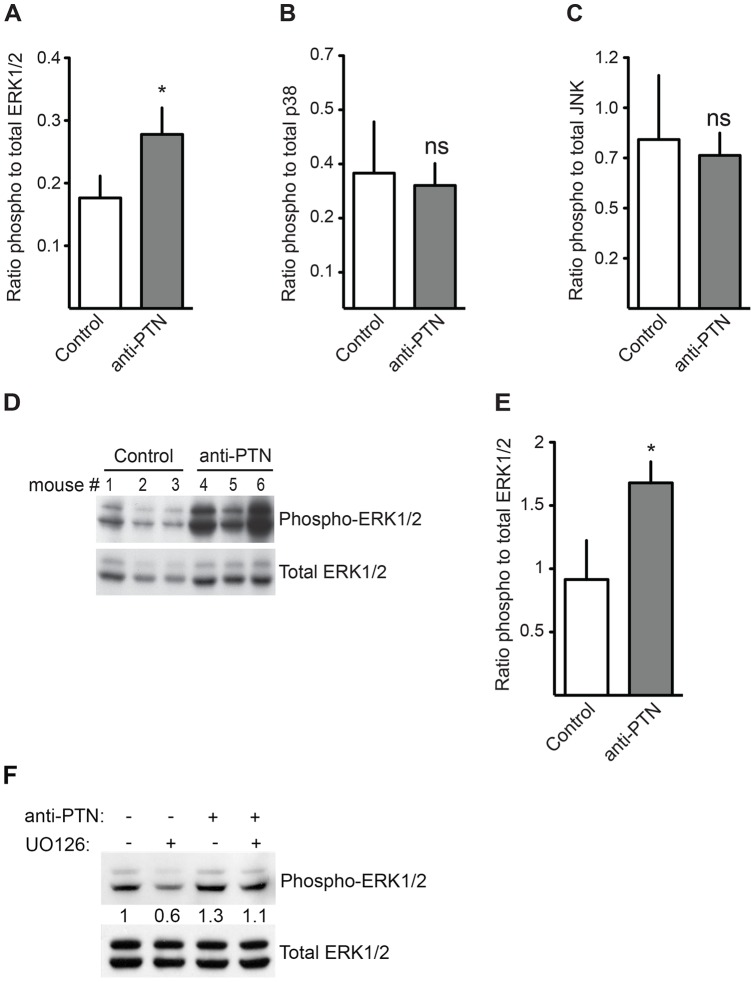
PTN effect on MAP kinase pathway activity in developing mammary glands.Phospho-ERK1/2 (A), phospho-p38 (B), and phospho-JNK (C) in whole mammary gland extracts from anti-PTN treated mice (n = 10) versus controls (n = 9). The ratio of phospho- to total protein was obtained from multiplex assays. Ns, not significant; *P<0.05. (D, E) Western blot analysis for pERK1/2. Representative Western blots (mouse m1 to m6) and quantitation of phospho ERK1/2 relative to total ERK1/2 in 3 independent experiments (n = 9 to 10 per group). (F) Representative Western blots of whole cell lysates from MECs treated for 24 hours with either UO126 (500 nM) alone or in combination with anti-PTN blocking antibody and quantitation of phospho ERK1/2 relative to total ERK1/2. Numbers represent the ratio of the quantification of phospho ERK1/2 to total ERK1/2. Data are means ± SE; *P<0.05.